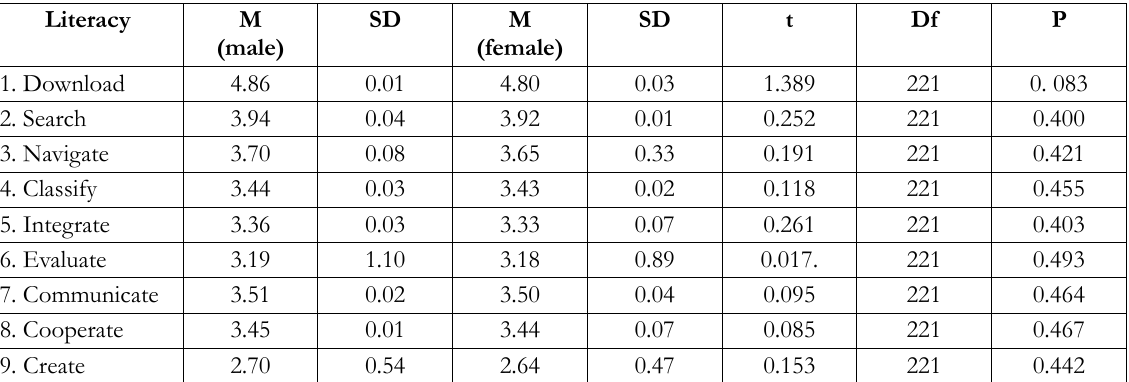
Table 9. The difference in perceived